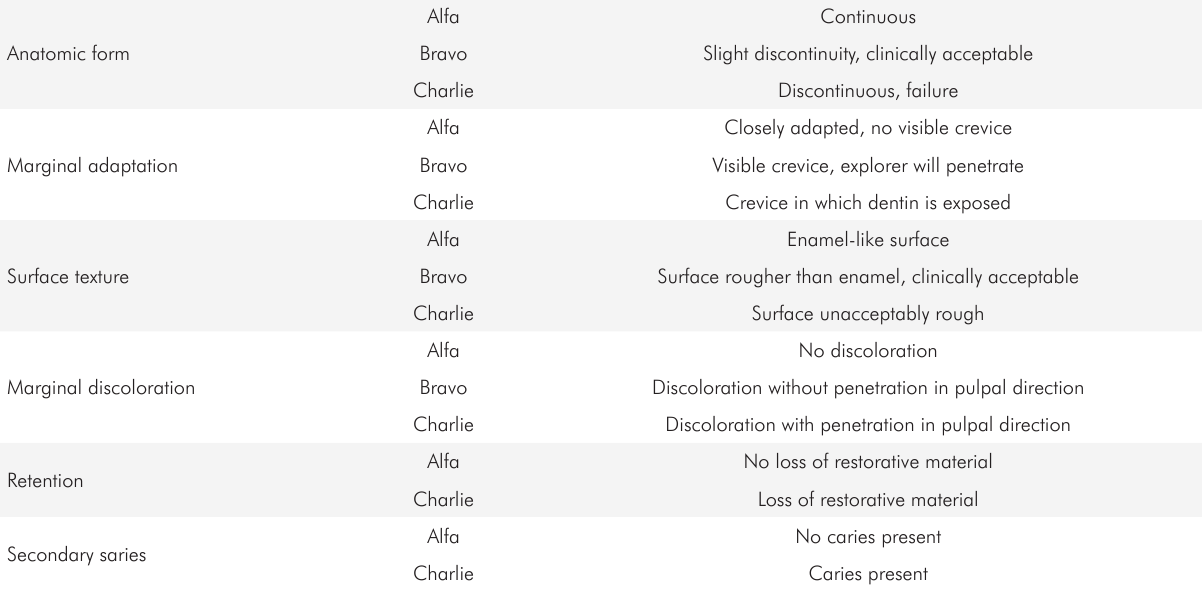
Table 2. United States Public Health Service-Modified classification of teeth as satisfactory or unsatisfactory. Anatomic